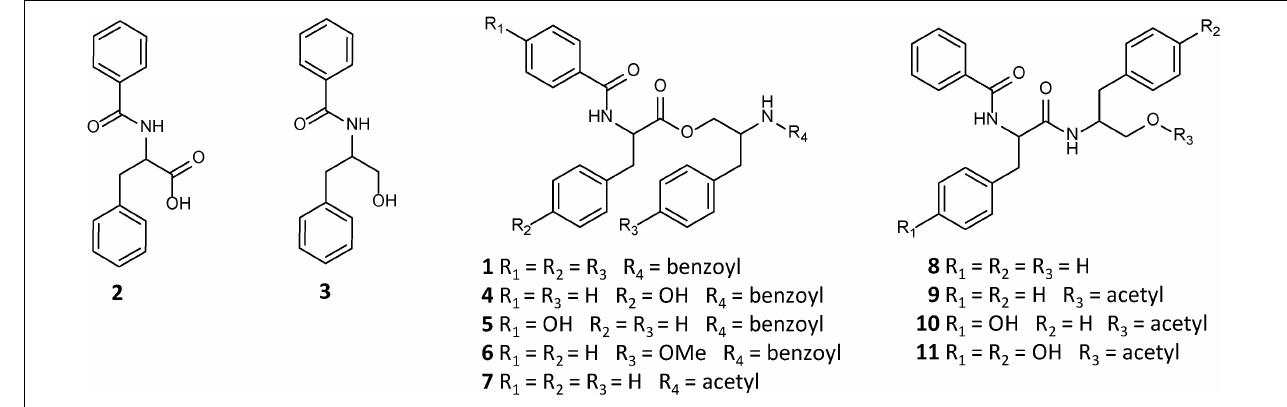
FIGURE 1 | Structures of natural asperphenamate